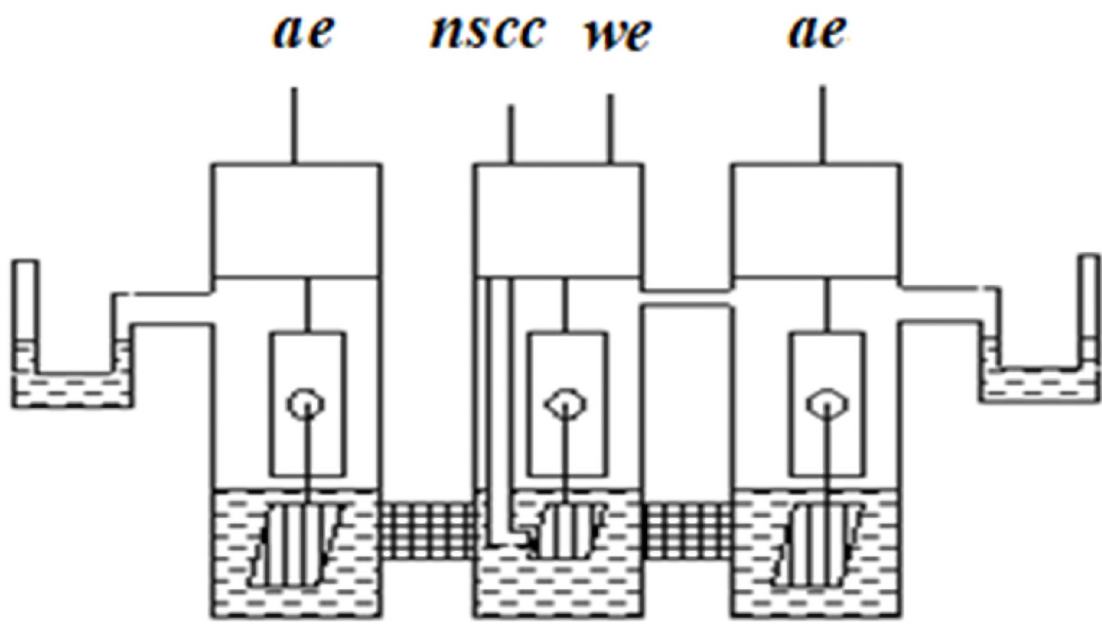
Fig 2. Three-electrode cell with separated Schott filters with cathode and anode spaces. ae–auxiliary, we–working, nscc–normal reference electrodes with silver chloride.